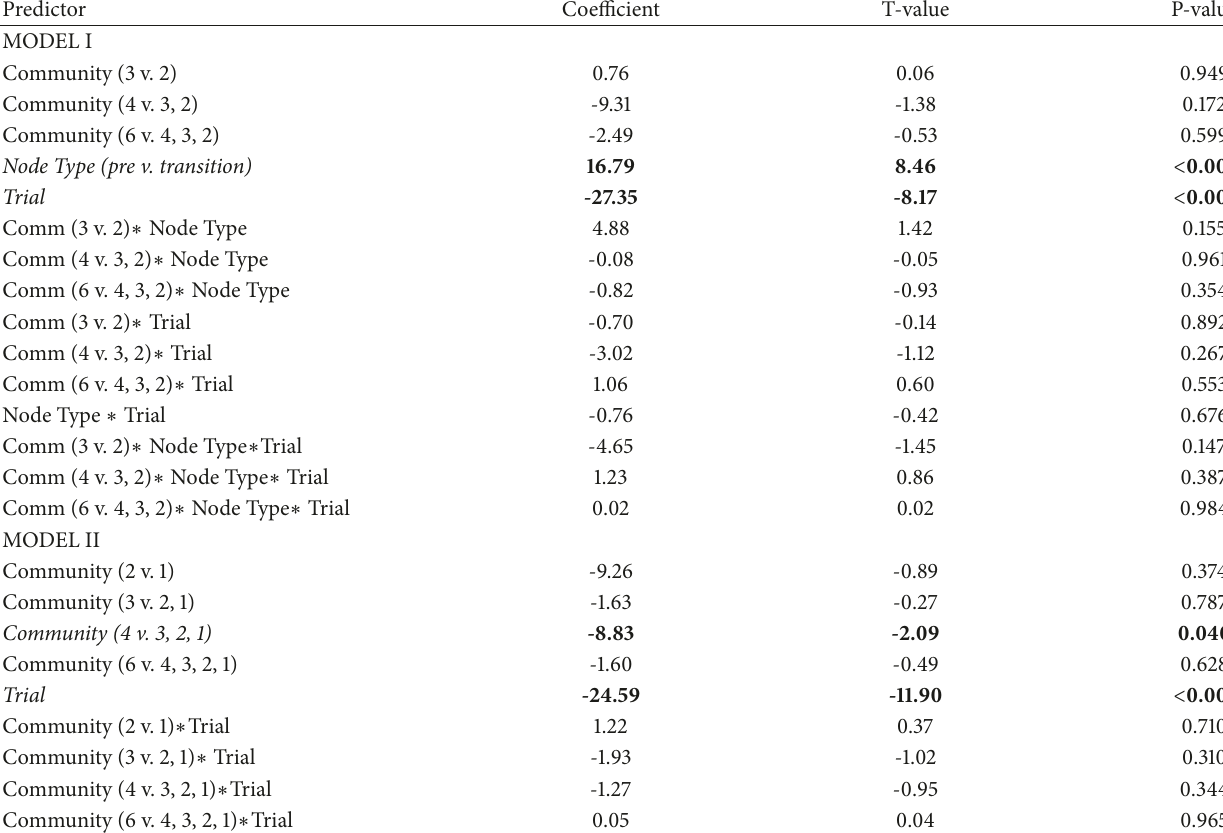
Table 1: Model I lists the coefficients, t-values, and p-values for each predictor in a model examining the effect of Node Type (pre-transition versus transition), Community (reverse-Helmert coded based on graph type), Trial, and their interactions on RTs specific to boundary nodes. Model II lists these values for predictors in a model examining the effect of Community, Trial, and the interaction of these predictors for all nontransition RTs. Significant values (corresponding to p < 0.05 via the Sattherwaite approximation) are